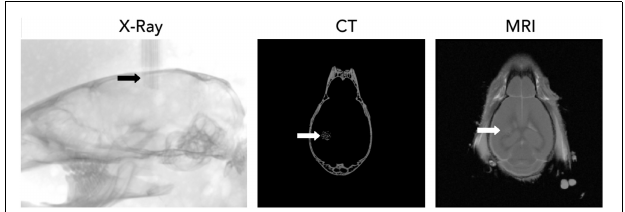
FIGURE 5 | Localization of CHIME microwire bundles using X-ray computer tomography (CT, left: individual X-ray projection) and magnetic resonance imaging